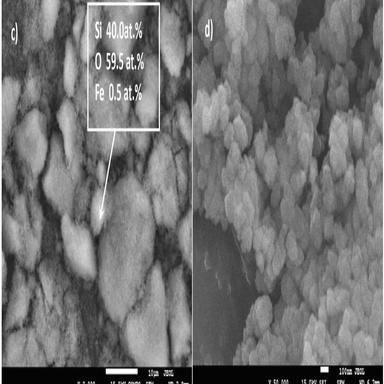
SEM images for Fe1.0HAlBEA (a-b) and Fe1.0SiBEA (c-d).